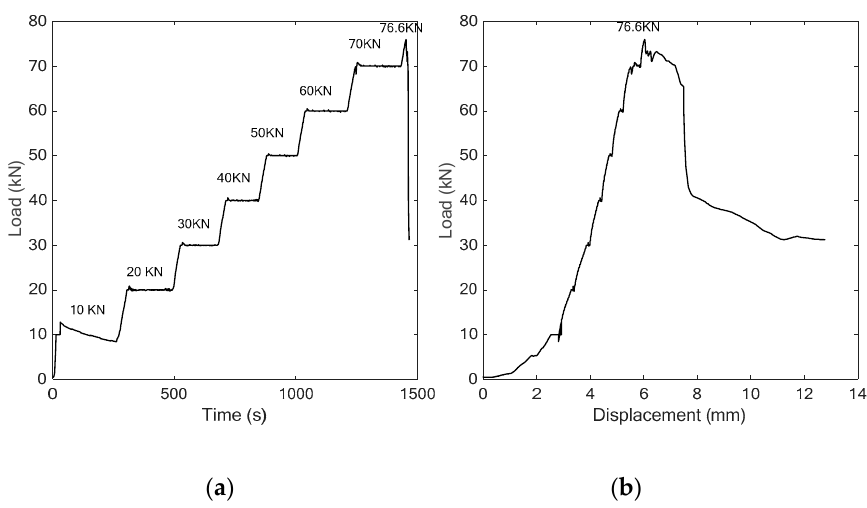
Figure 10. The curves of ( a ) time vs. load, ( b ) displacement vs. load.